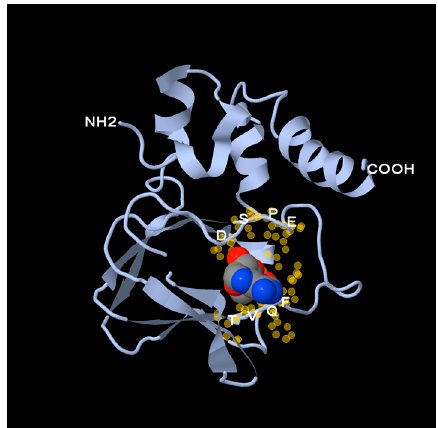
Figure 3. Structure of the Popeye domain. A homology-based structural model of human POPDC1 was generated. A space-filling model of cAMP was placed in the putative phosphate-binding cassette. The DSPE and FQVT motifs, depicted as yellow halos, surround the cAMP molecule and as mutagenesis studies suggest, seem to be directly involved in cAMP-binding.